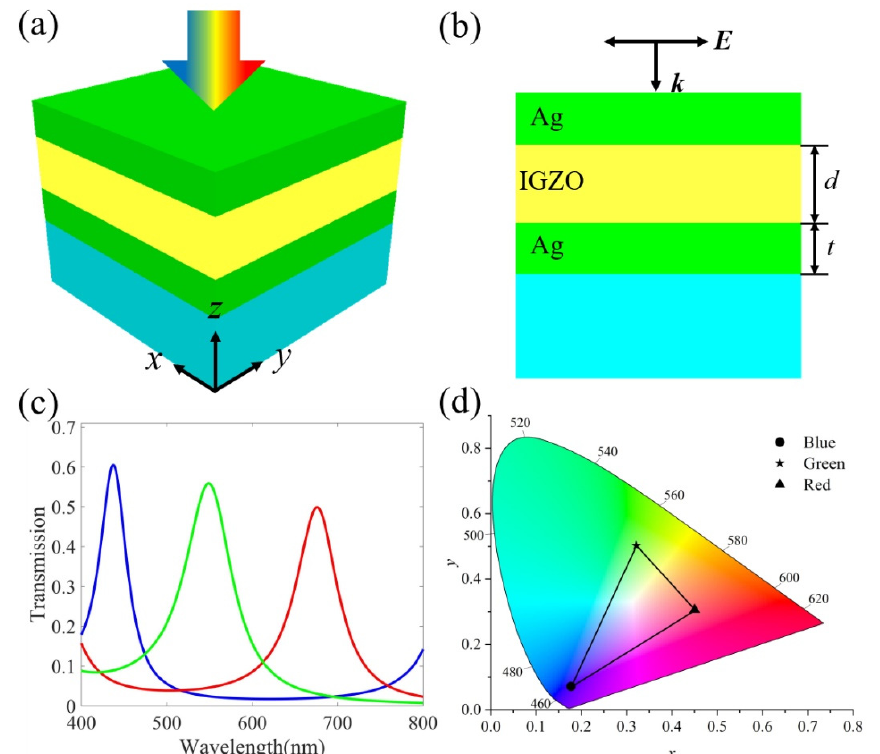
Figure 2. ( a ) Schematic diagram of the proposed ultra-thin, high-efficiency color-changing filter; ( b ) cross-sectional view of the structure; ( c ) the calculated transmission spectrum at normal incidence. T = 30 nm and d = 170 nm, 90 nm and 125 nm, respectively; ( d ) the corresponding chromaticity diagram of the RGB structural color.